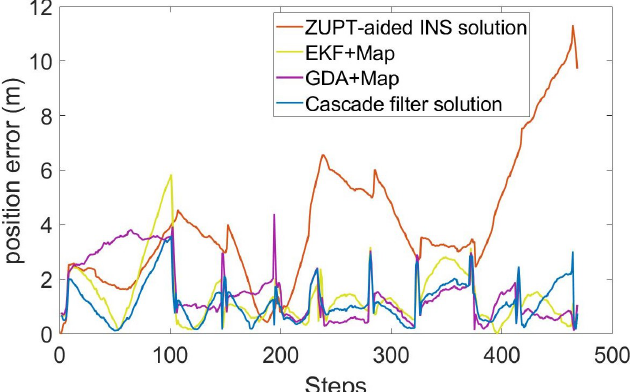
Figure 7. Position error of each step.